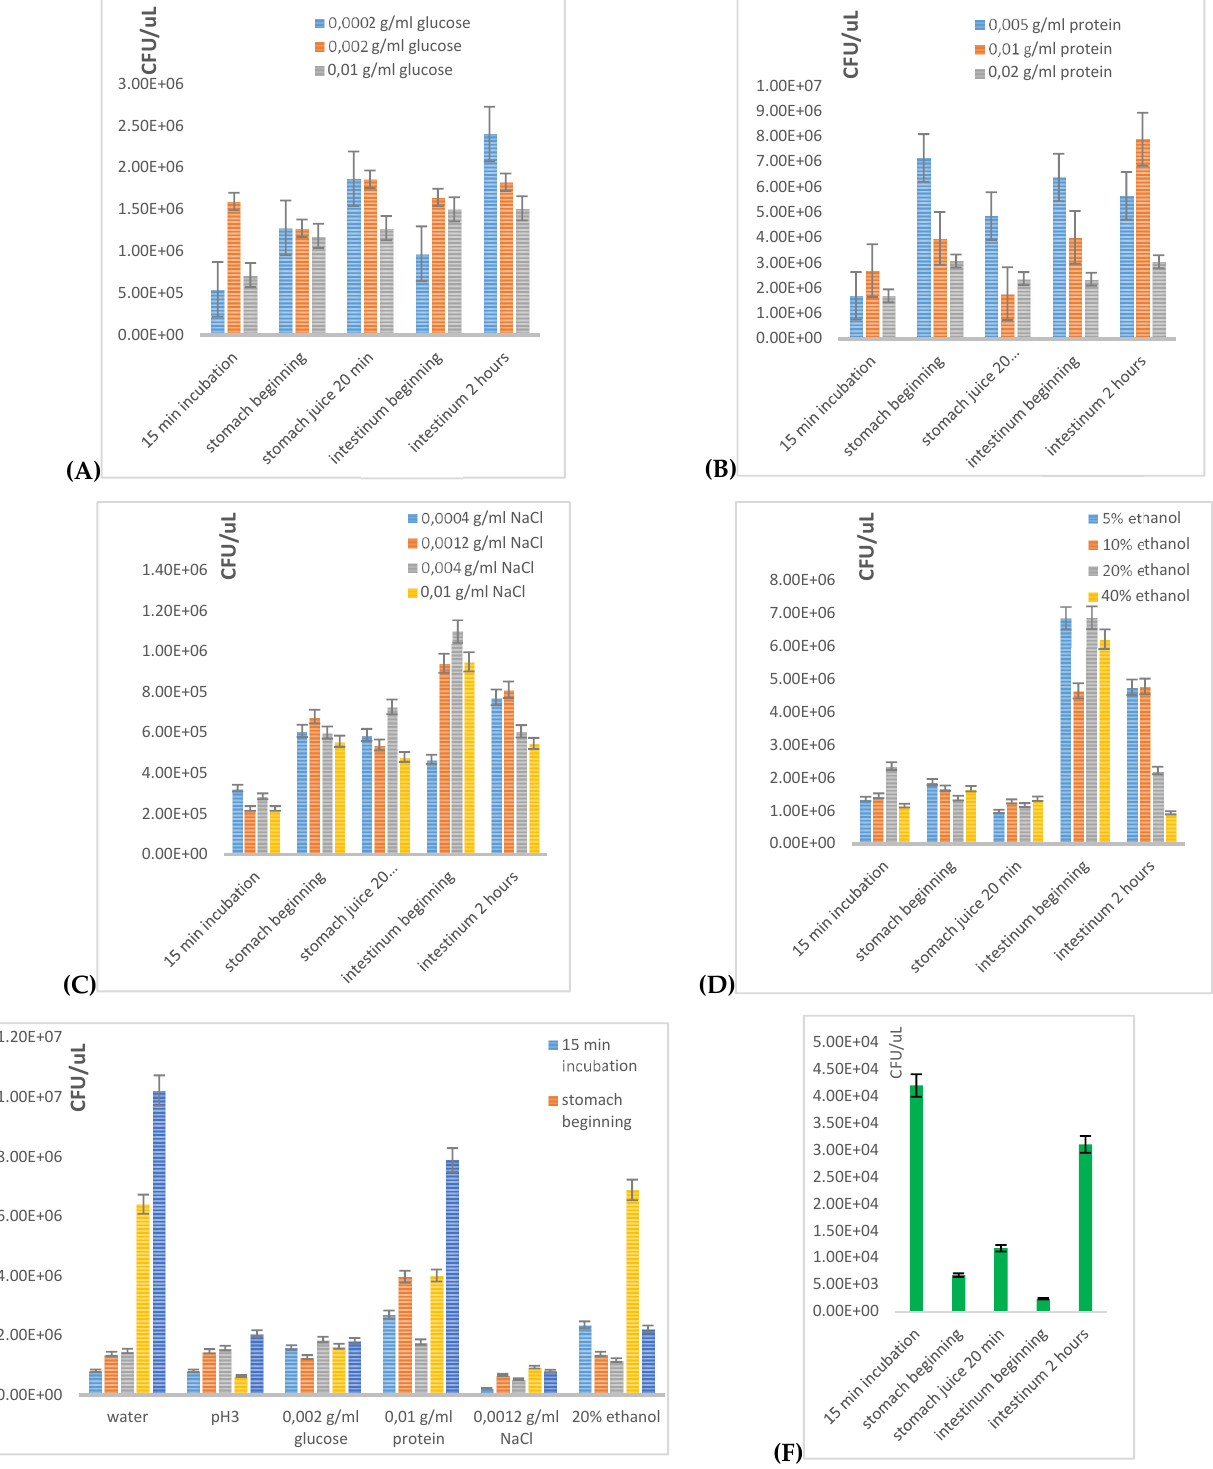
Figure 1. Viability of mixed culture of lactic acid bacteria during the process of digestion of model foods containing probiotics (commercial probiotic mixture): ( A ) sugar concentration, ( B ) protein concentration, ( C ) salt concentration, ( D ) alcohol concentration, ( E ) comparison of model factors, pH 3 was set by acetic acid, and ( F ) incubation of cell suspension directly in digestive fluid.